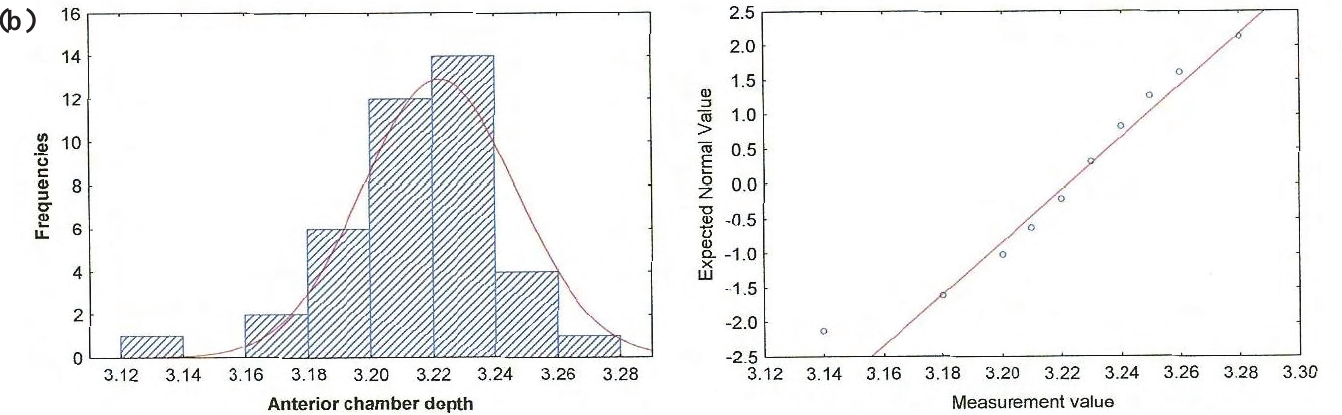
Figure 11. Histogram and normal probability plots for the CCT (a) and AACD (b) samples of subject 8. The CCT sample was ap- proximately normally distributed, the p -value was greater than 0.05 but less than 0.05 for the AACD in the SW-W